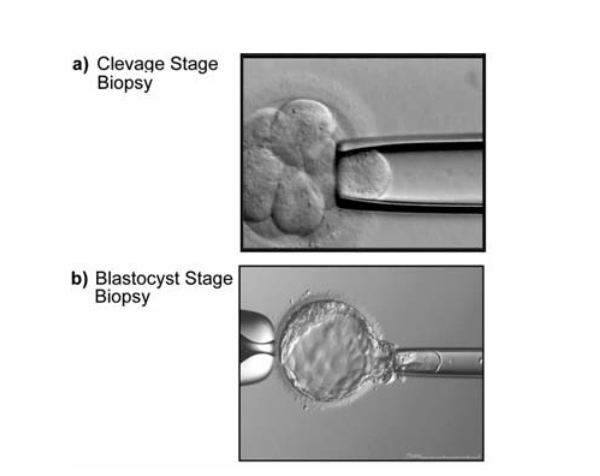
Figure 1. Polymorphic STR markers used in HLA typing of the embryos.